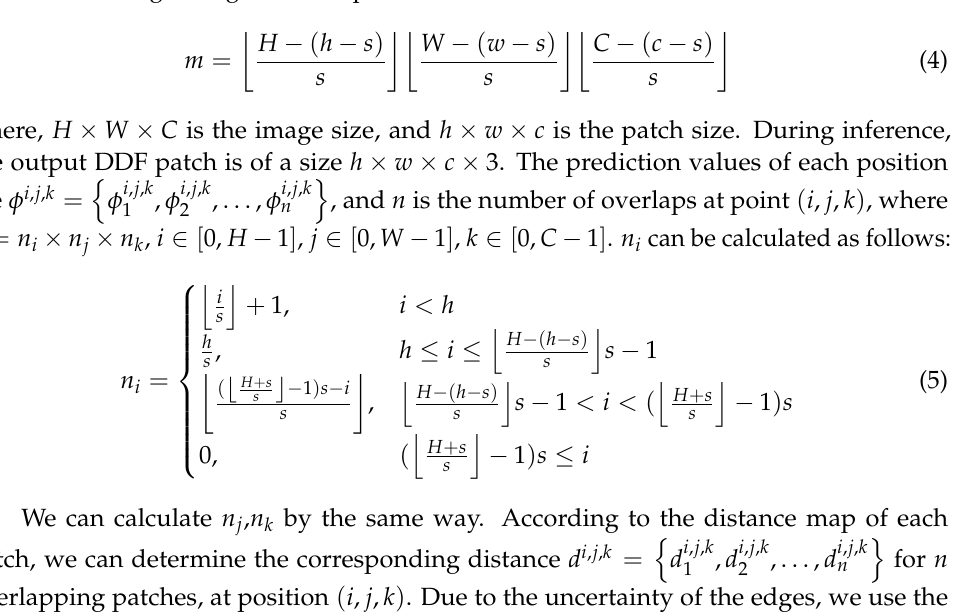
φ and φ , respec- B A d is the distance 2 and ω B = e − d 2 . Finally, e − d 1 + e − d 2 e − d 1 + e − d 2